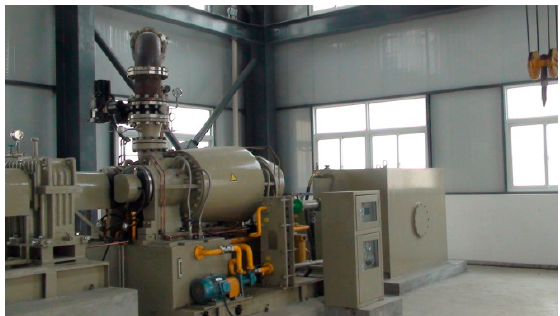
Figure 1. The second screw expander generating unit in YangBaJing geothermal power plant.